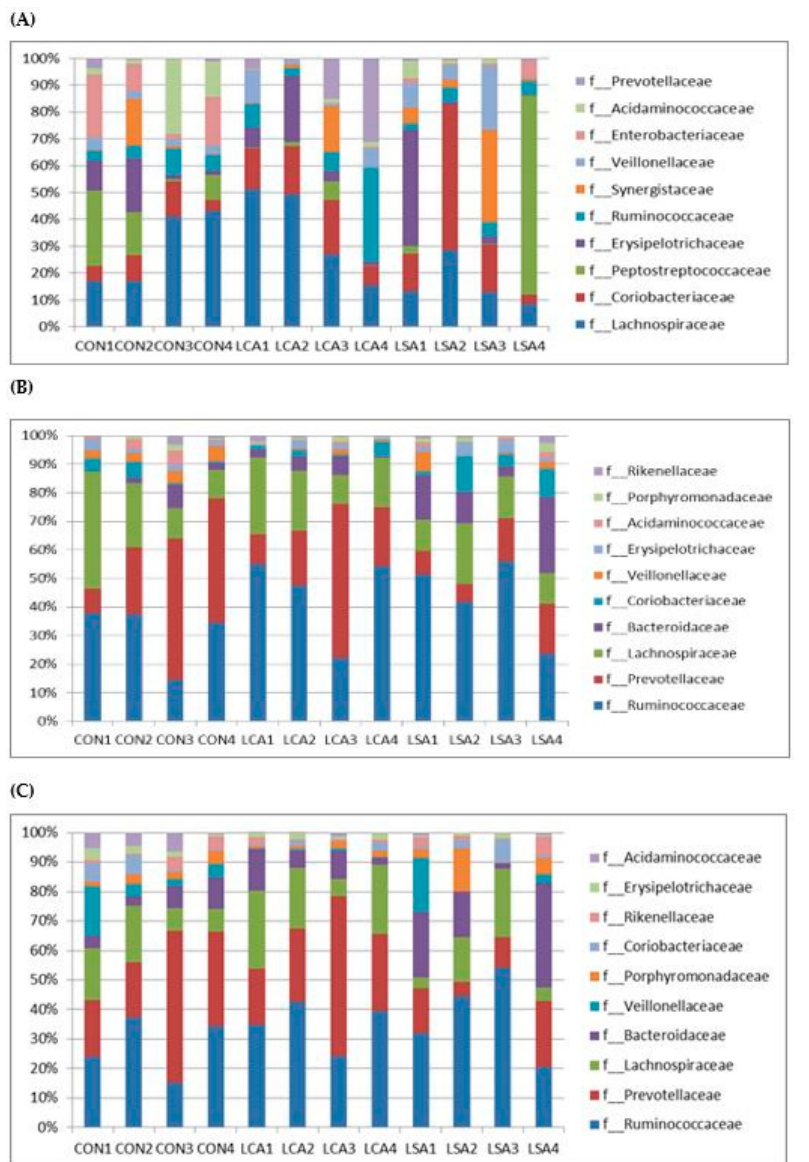
Figure 3. Effect of feeding MR with low antibiotics concentration cocktail or single on the family distribution in the ileum, colon and rectum. A = ileum; B = colon and C = rectum. CON = control; LCA = low cocktail of antibiotics concentration; LSA = low concentration of single antibiotic. The values are the mean plus standard deviation.